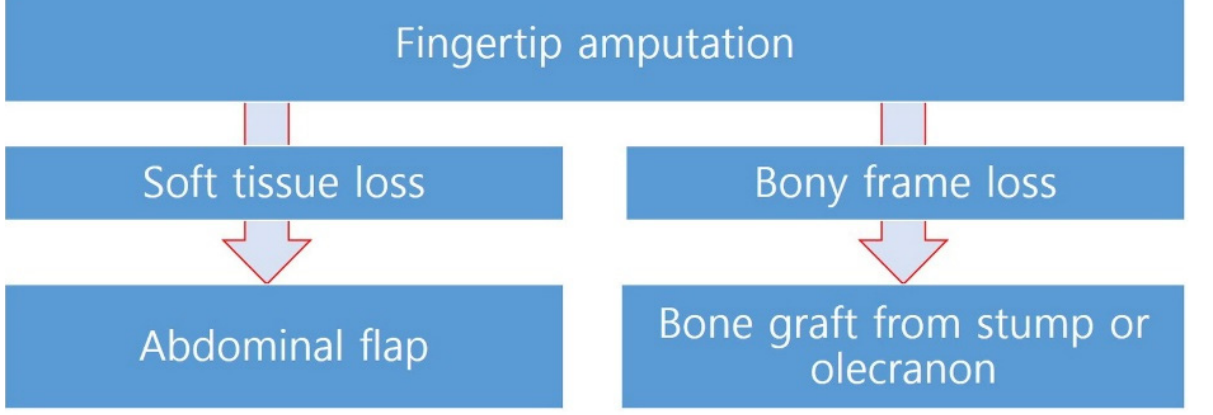
Figure 1. Algorithm for hybrid abdominal flap.